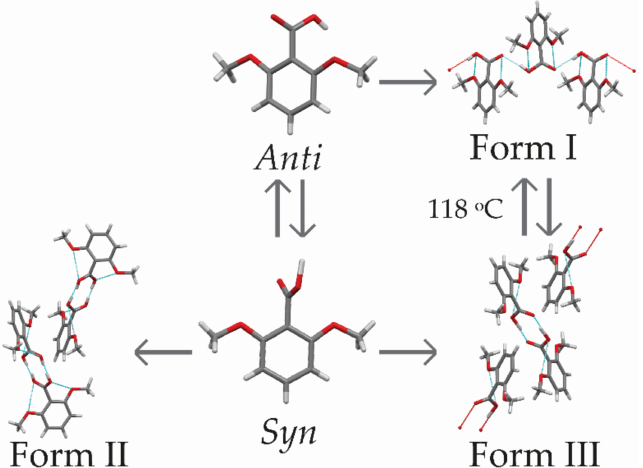
Figure 2. Relationships between 2,6MeOBA conformations and polymorphs. The connection between forms I and III is elucidated in this study.